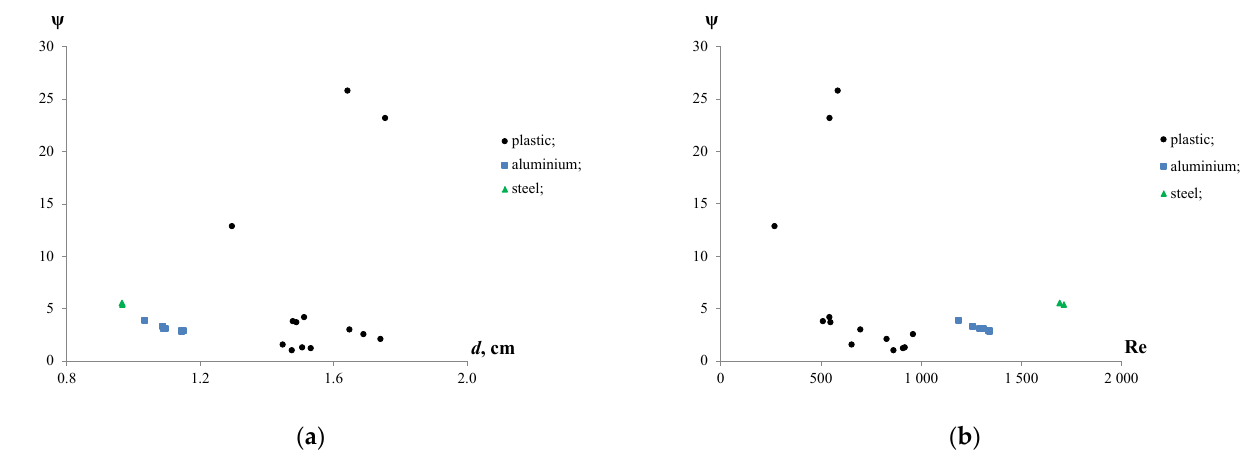
Figure 6. Drag coefficient for plastic, iron and aluminium particles with various d e ( a ) and Reynolds numbers ( b ).